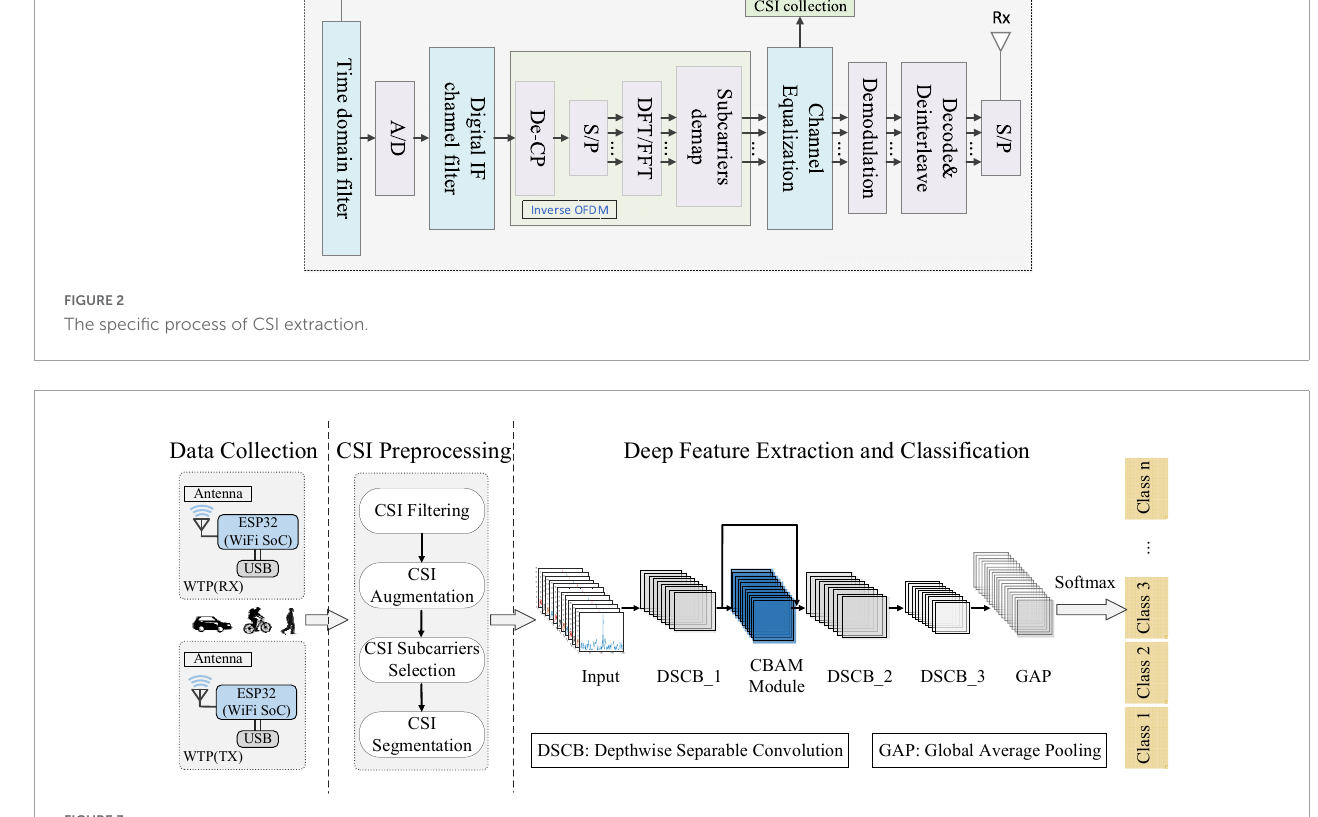
FIGURE3 Overview of the proposed WiHVR based on a lightweight wireless sensing attention-based deep learning model